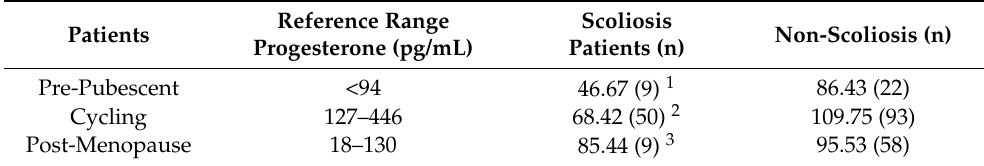
Table 4. Progesterone values compared to laboratory reference ranges.